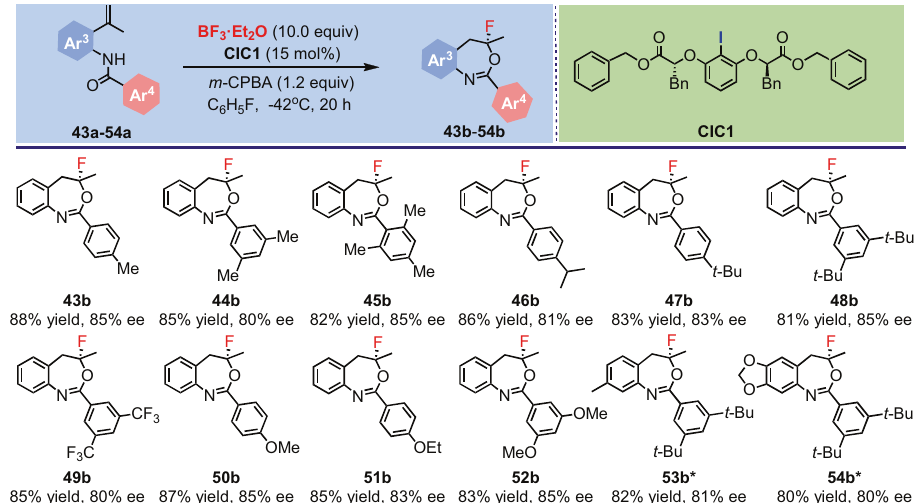
Fig. 4 Substrate scope expanding of the nucleophilic asymmetric fl uorinations using BF 3 ·Et 2 O as the fl uorine source. Reactions were conducted on a 0.2 mmol scale with 10.0 equivalents of BF 3 ·Et 2 O in C 6 H 5 F (8.0 mL) at − 42 °C for 20 h; isolated yields are reported. * CIC2 was applied as the catalyst for the formation of 53b and 54b . The ee values were determined by chiral HPLC analysis. Me, methyl; t -Bu, tert -butyl; Et, ethyl.